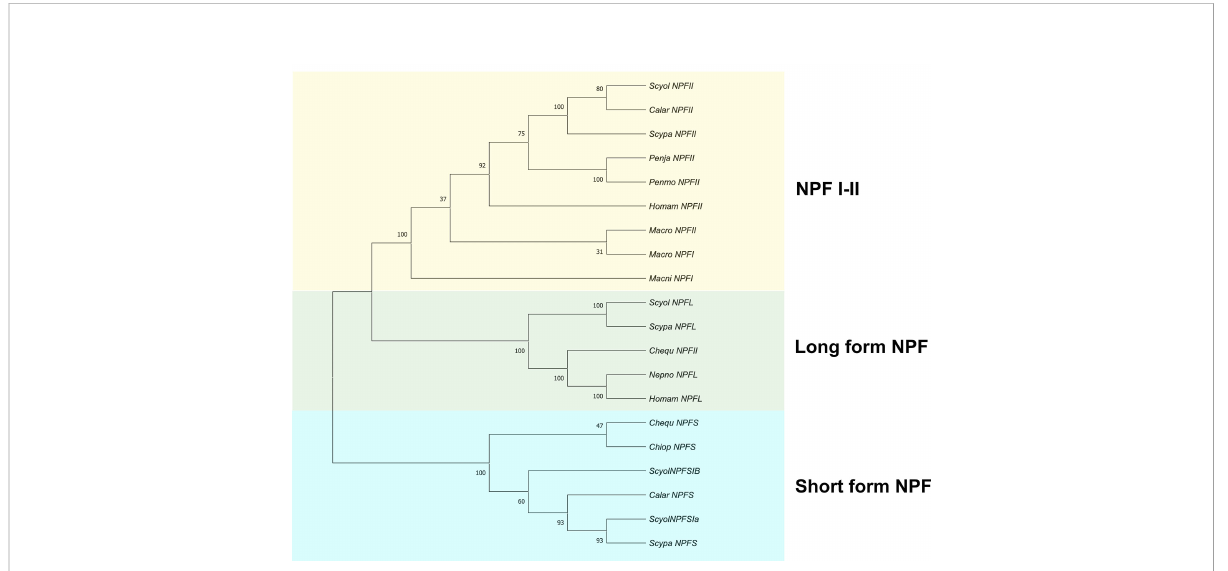
antibody had intense staining in the ON and the neuronal cluster 9/11 of S. olivacea tissue (Figure 10B). On the other hand, no NPF-ir was shown after the pre-absorption of the anti- Macro - NPF I antibody and the synthetic Scyol -NPF II peptide on the S. olivacea tissue were applied (Figure 10C).